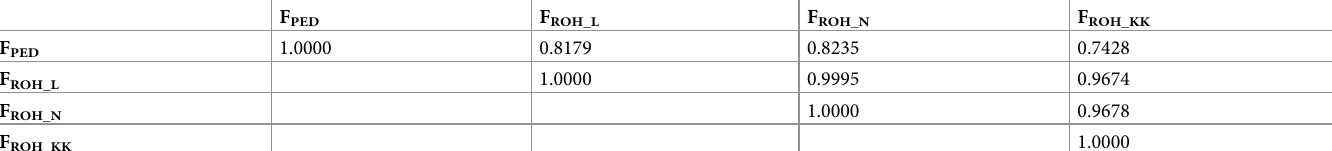
Table 5. Correlation coefficients between different measures of inbreeding calculated based on 31 German White-headed Mutton individuals (P-values < 0.001 in all cases). F PED